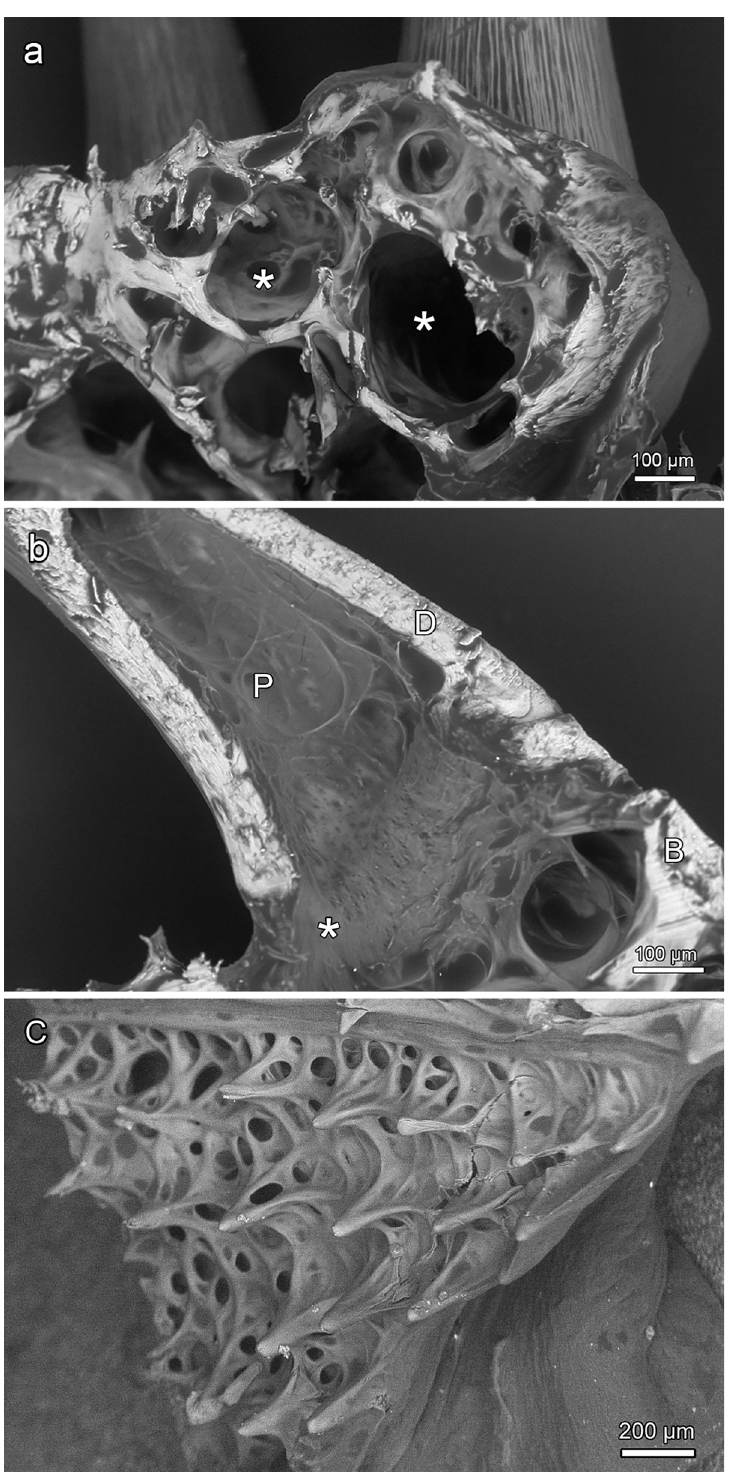
Fig 12. SEM-BSE images of teeth and dentigerous bone (a, b) and bony projections (odontoids) (c) in the oropharynx of Anoplogaster cornuta . (a) Multiple cavities (asterisks) are present in the entopterygoid. (b) Broad connection between pulp cavity (P) and cavities in the dentigerous bone (B) (entopterygoid). Note collagenous connection (asterisk) between tooth base and bone. D: Dentin. (c) Bony projections (odontoids) emanating from a mesh-like bone in the roof of the oropharynx. Posterior to left of